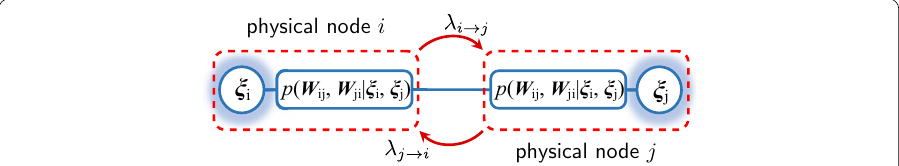
Fig. 6 (cid:31) i → j = (cid:31) p and (cid:31) j → i = (cid:31) p are the BP messages exchanged between physical nodes in ij → ξ i ij → ξ j